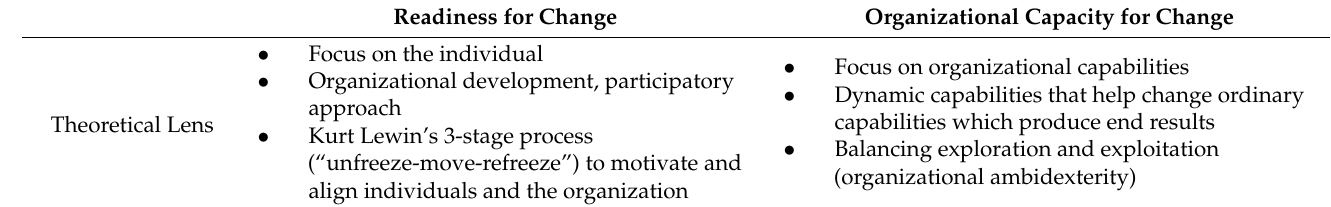
Table 1. Theoretical